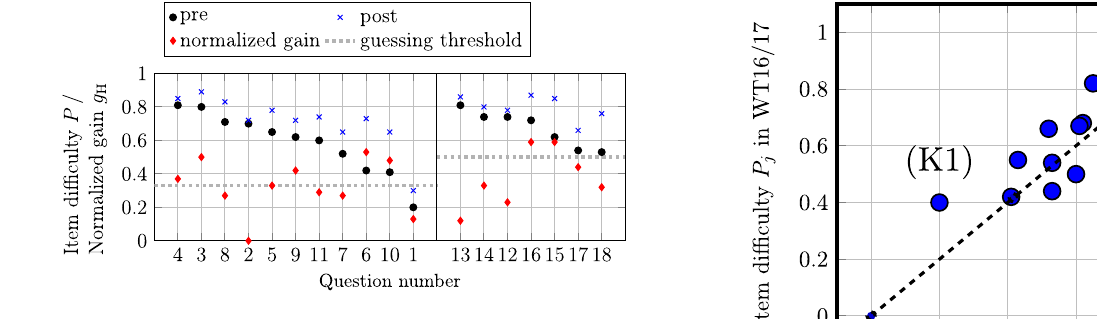
FIG. 6. KiRC results by question for the introductory physics course ordered by pre-instruction item difficulty. The left part of the diagram shows the MC3 items; the right part shows the MTF items.